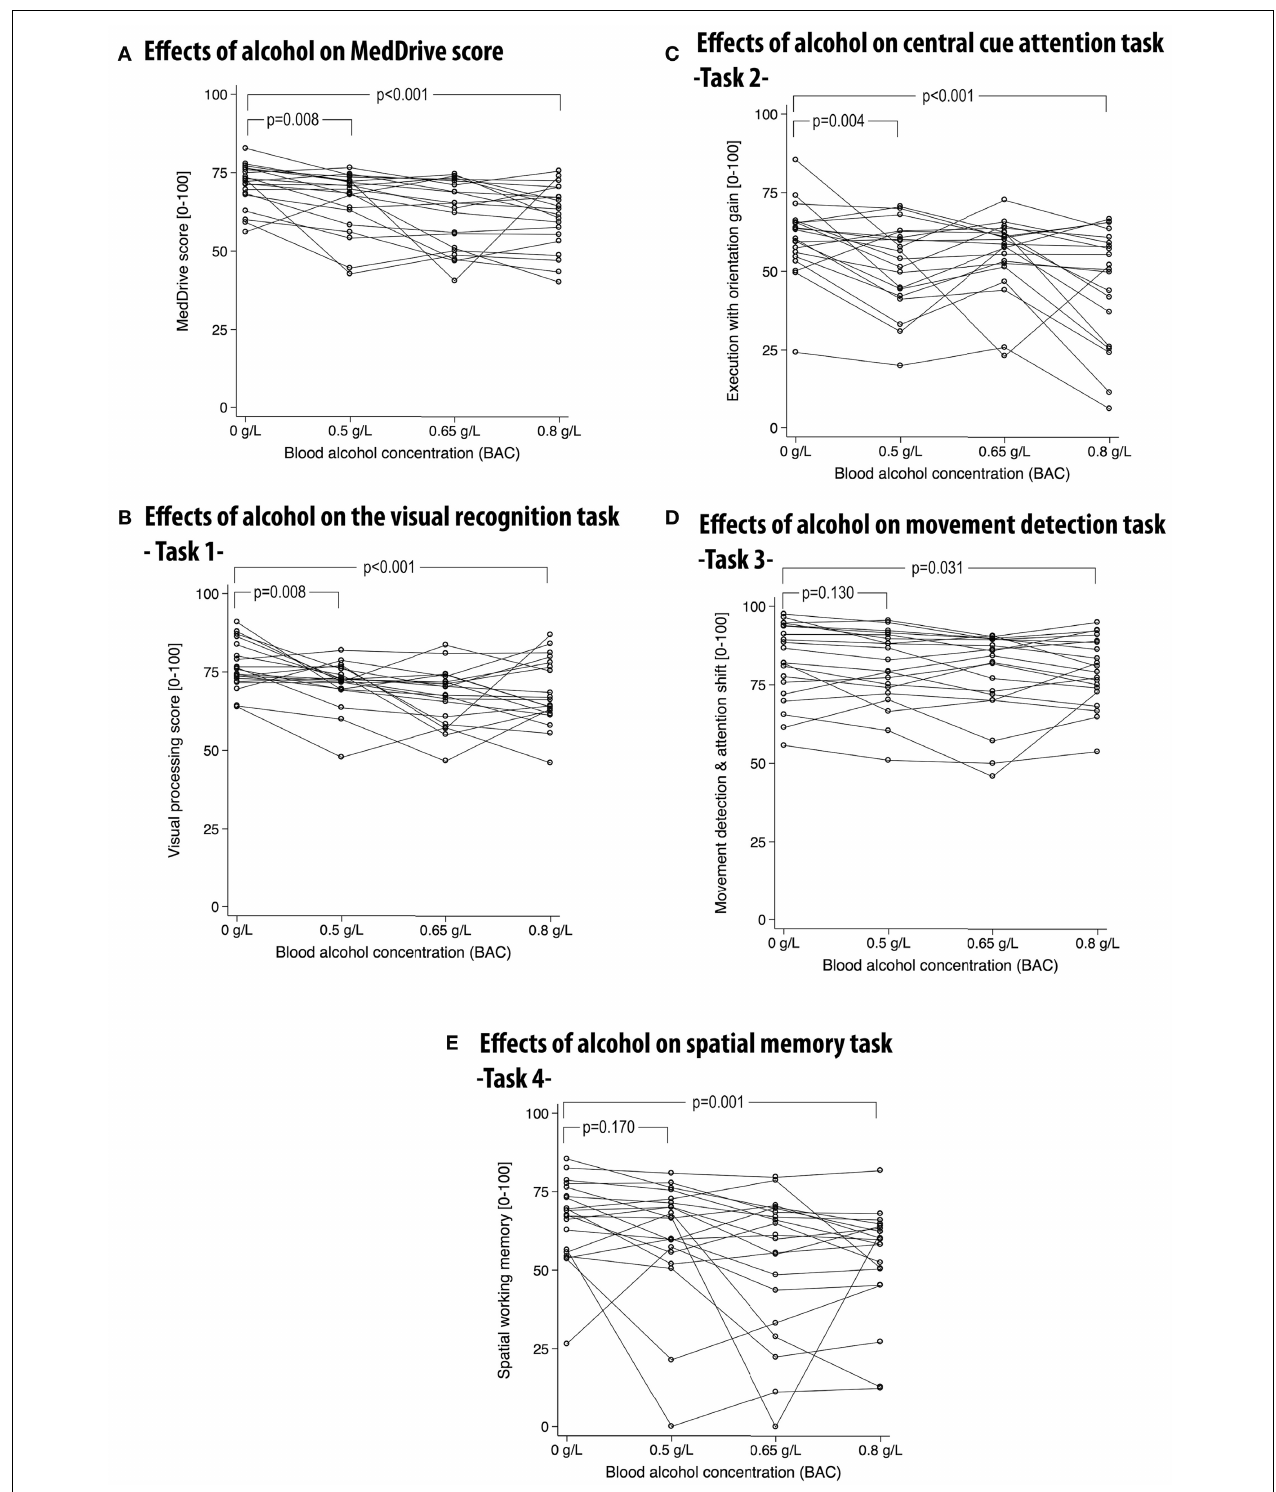
FIGURE 6 | Effects of alcohol on the overall MedDrive score (A) and for each of its composing subtasks (B–E). MedDrive’s responsiveness to different blood alcohol concentrations. Lines represent changes of performance across different blood alcohol concentrations (BACs). Lower